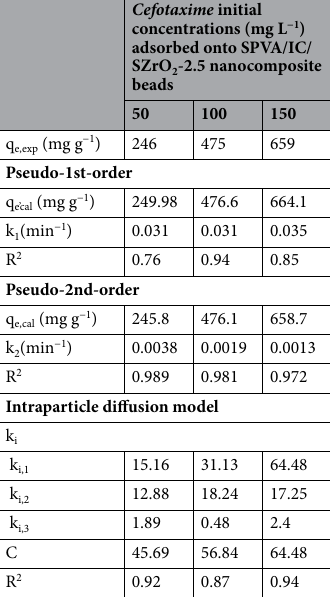
Table 2. Kinetic models’ parameters and determination coefficients for Cefotaxime adsorption onto SPVA/IC/ SZrO 2 -2.5 nanocomposite beads.